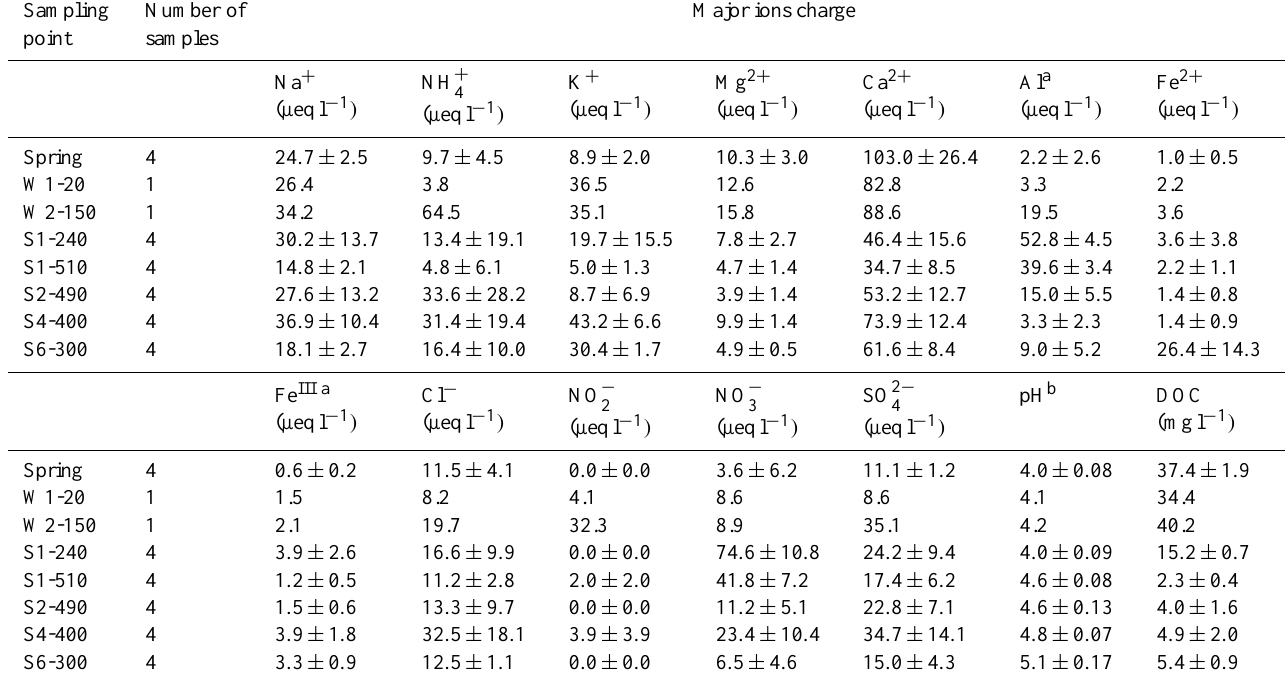
Table 3. Major ions charge, DOC and pH (average ± standard deviation). Sampling point